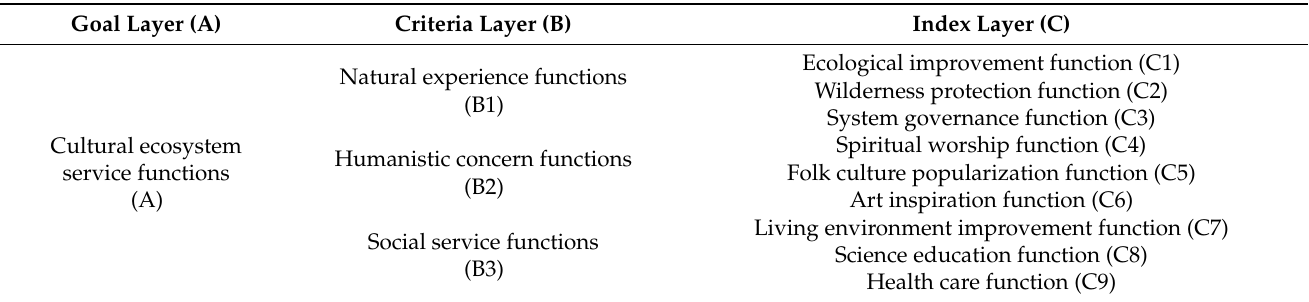
Table 1. Evaluation index